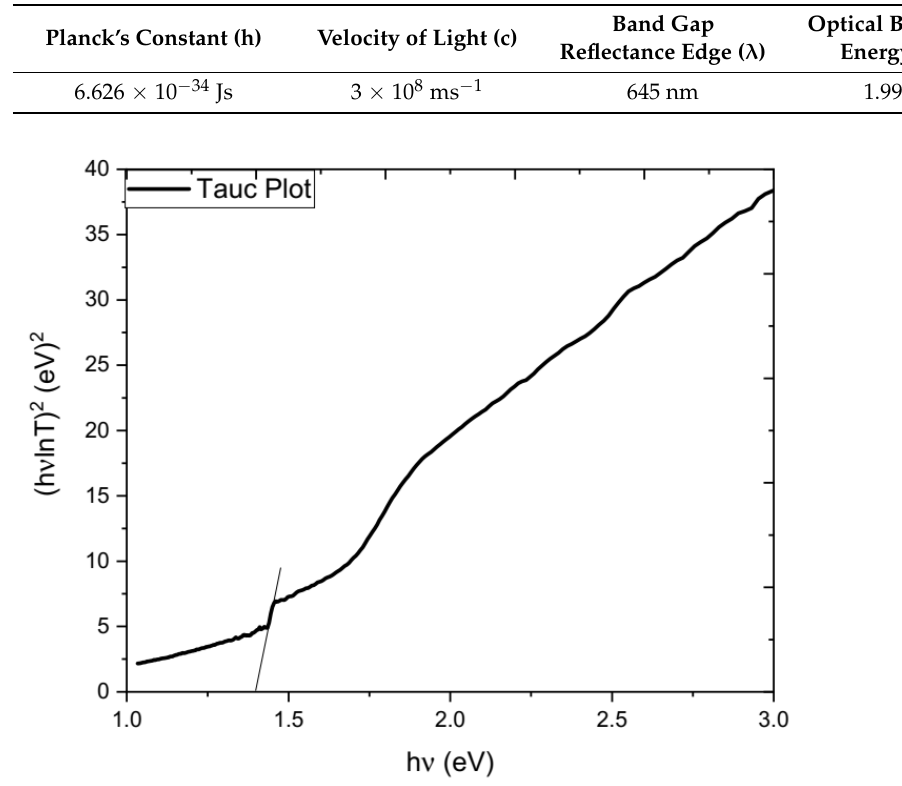
Figure 5. Tauc’s plot of biogenically synthesized NiO